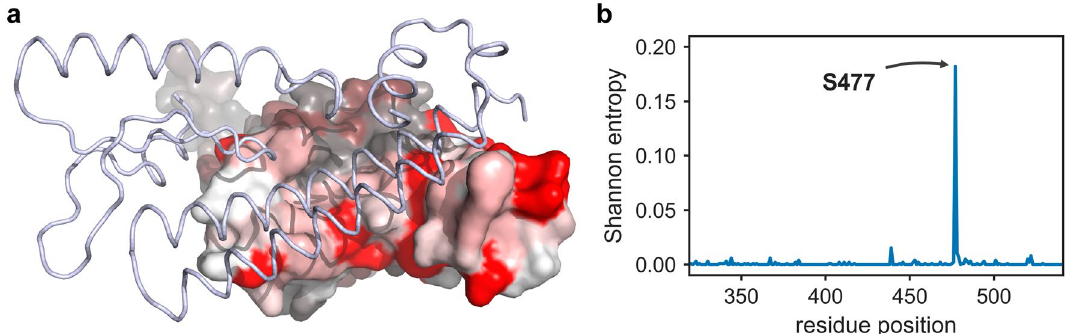
Figure 1. Sequence analysis for reported mutations in RBD. ( a ) Surface representation of the RBD coloured according to the conservation score at the respective residue position. Conserved residues are shown in white and shades of red represent increasing variability. A portion of hACE2 is shown in a light blue ribbon representation. ( b ) Reported mutations in RBD shown as Shannon entropy vs. residue position. The Shannon M P i ln 2 P i , where M is the total number of residue positions and P i corresponds to (cid:31) entropy is given by H = − i = 1 probability of residue at position i . A higher entropy value indicates a less conserved